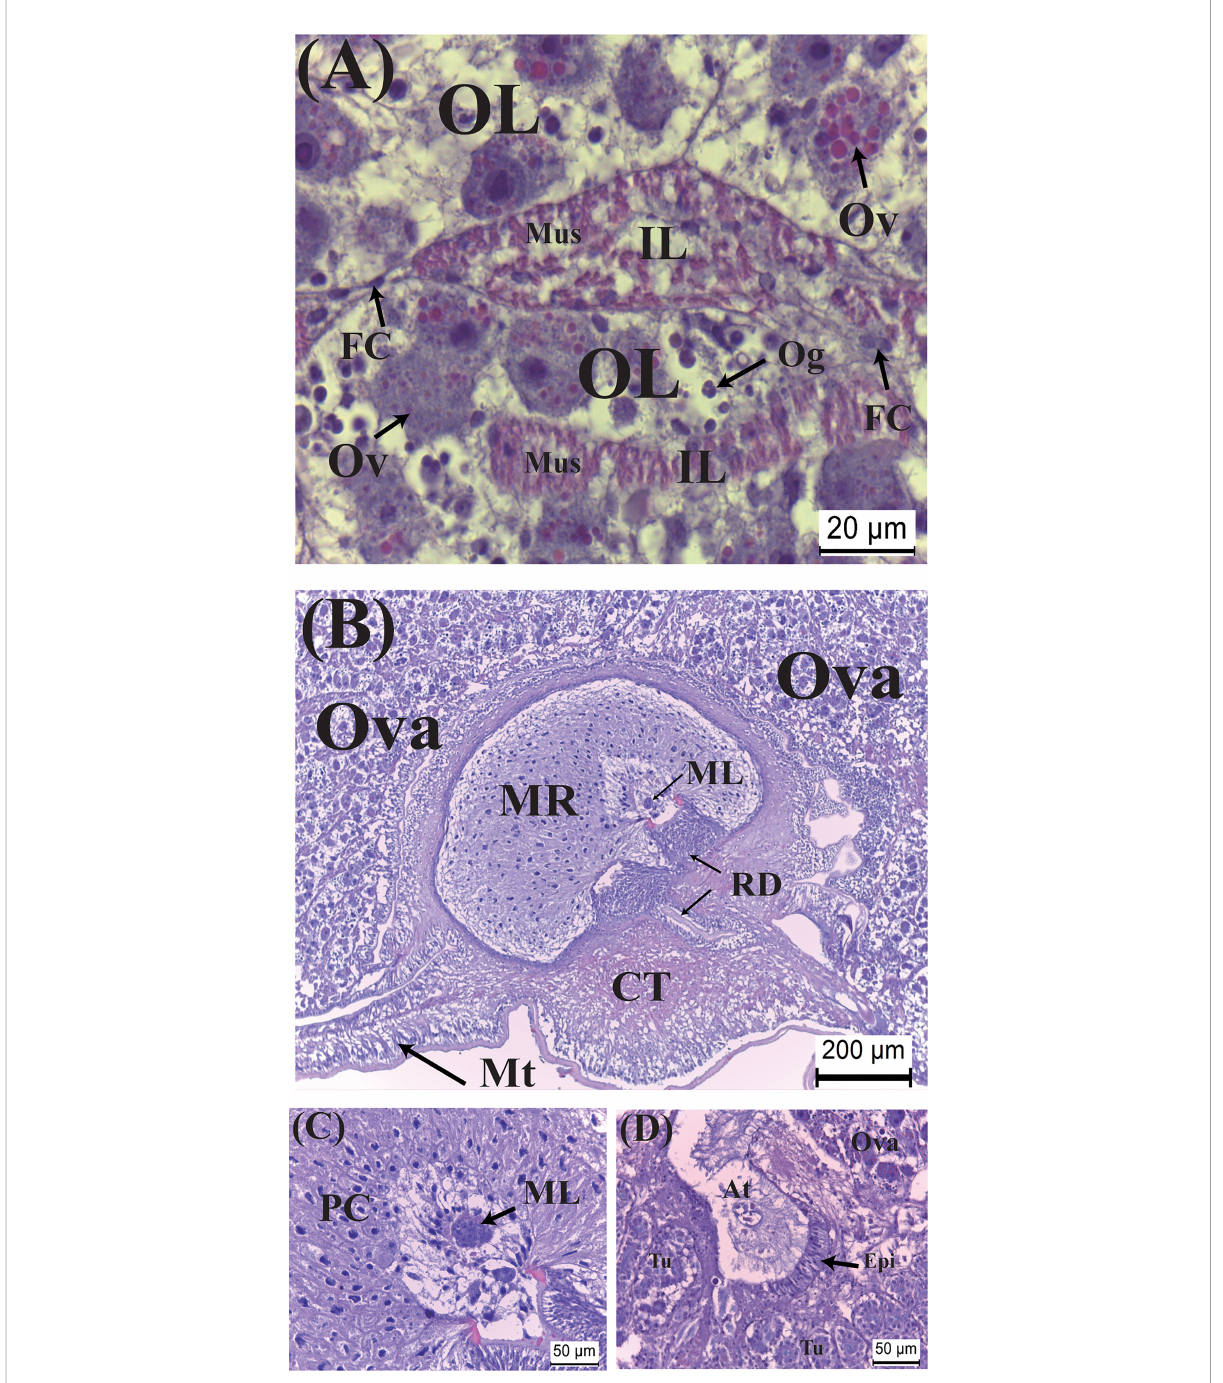
FIGURE 3 Developmental characteristics of the externa of Polyascus planus parasitizing the thukuhar shore-crab ( Metopograpsus thukuhar ) in the Creamy stage. In this stage, (A) vitellogenesis commences, with yolk granules being formed within the cytoplasm of vitellogenic oocytes, (B, C) male larvae penetrate the male receptacle, and (D) the colleteric glands begin to develop. At, atrium; CT, connective tissue; ML, male larva; Ov, vitellogenic oocyte; PC, polygonal cells; Tu, tubule. Other abbreviations are as indicated in Figure